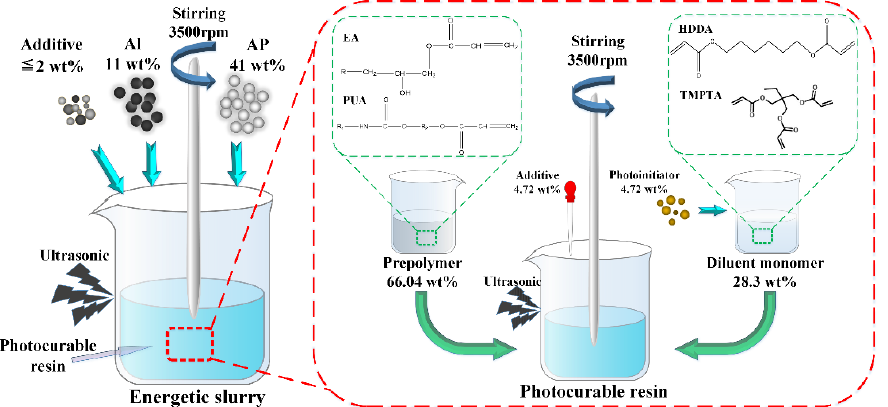
Figure 2. The preparation process of photocurable resin and the energetic slurry. Table 2. Description of the energetic slurry composition. Table 1. The formula of photocurable resin.